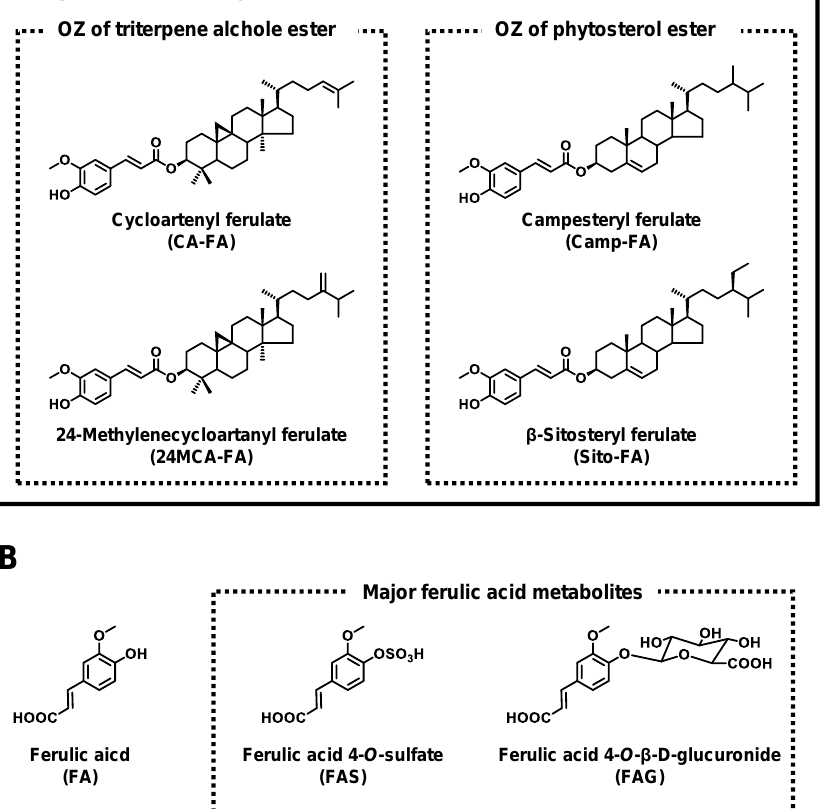
Figure 1. Chemical structures of principal γ-oryzanol (OZ) molecular species in rice bran (cycloartenyl ferulate, 24-methylenecycloartanyl ferulate, campesteryl ferulate, and β-sitosteryl ferulate) ( A ). Chemical structures of ferulic acid and major ferulic acid conjugates (ferulic acid sulfate and glucuronide) ( B ).